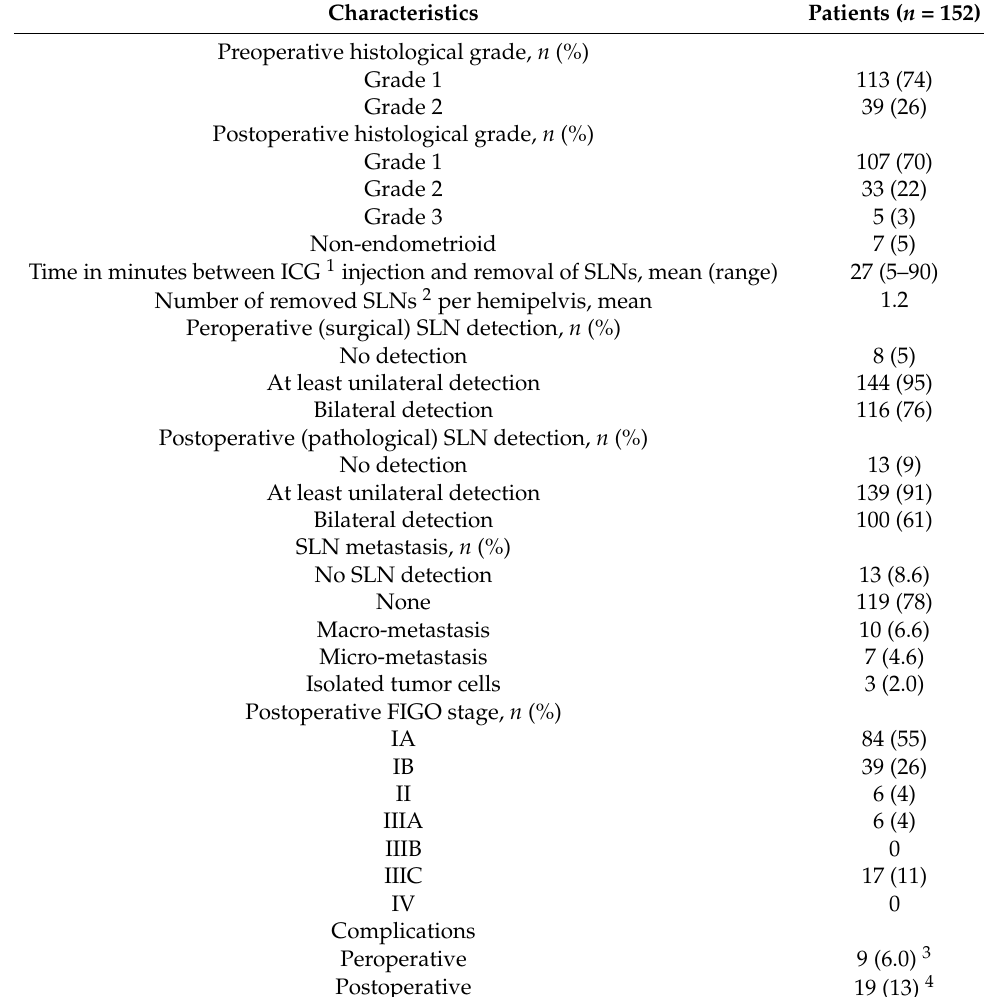
Table 1. Cont. Characteristics Patients ( n = 152) Preoperative histological grade, n